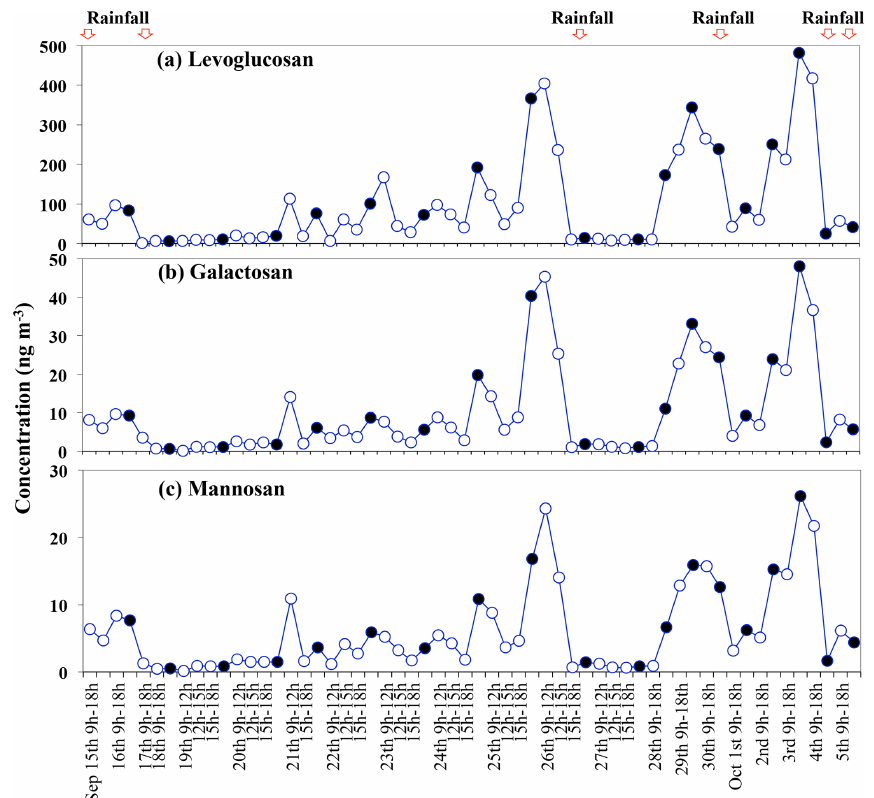
Figure 4. Temporal variations in the concentrations (ngm − 3 ) of anhydrosugars in the Mangshan aerosol samples collected for September– October 2007 (solid circle represents nighttime samples collected from 18:00 to 09:00; hollow circle represents daytime samples).